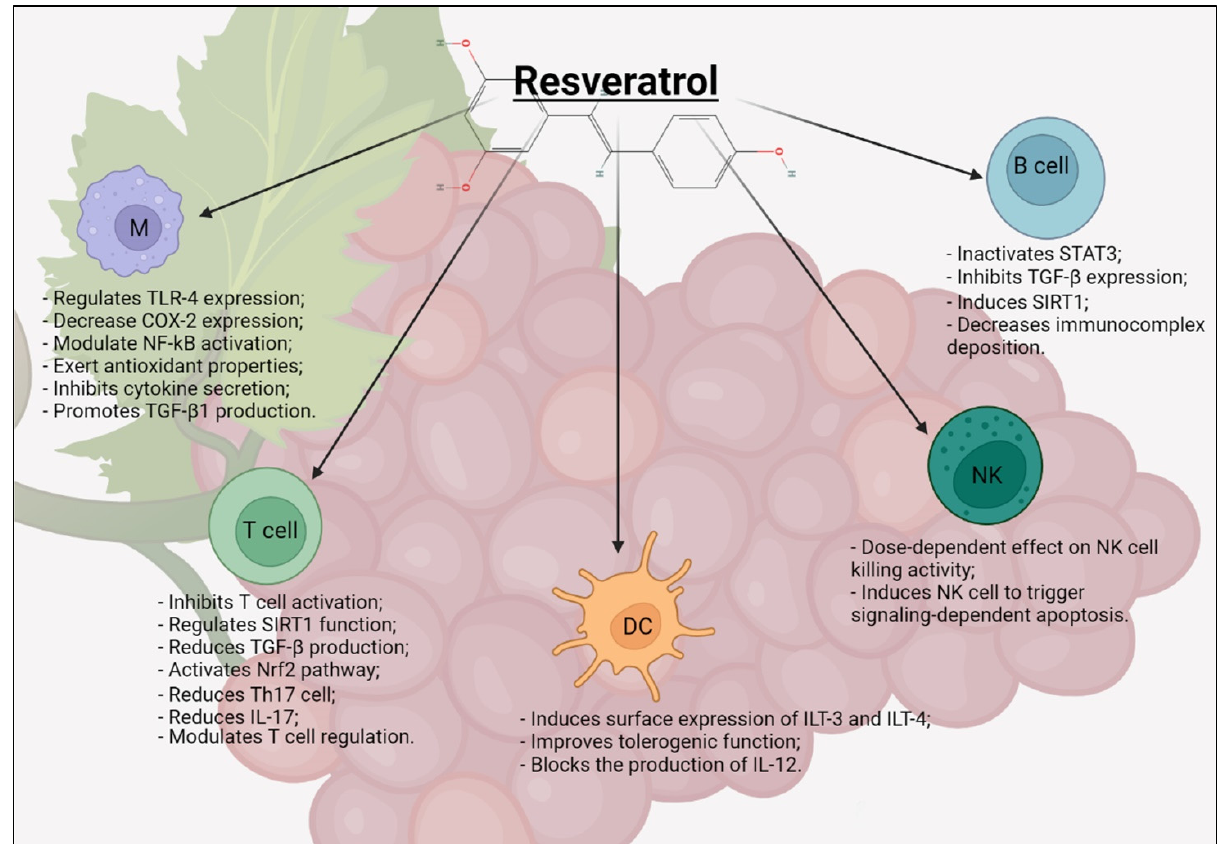
Figure 2. Scheme of RSV effect on immune cells. M = macrophage; DC = dendritic cell; NK = natural killer cell. Created with BioRender.com (Web online version 2021. Accessed on 28 December 2021).